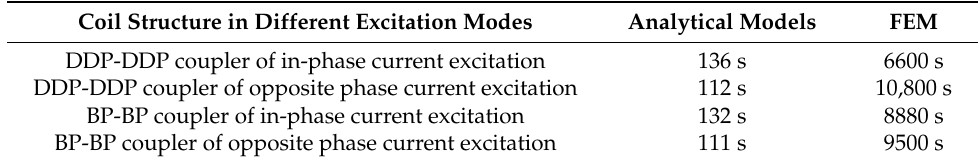
Table 3. Computational cost of the two modes under misalignment along the x -axis.